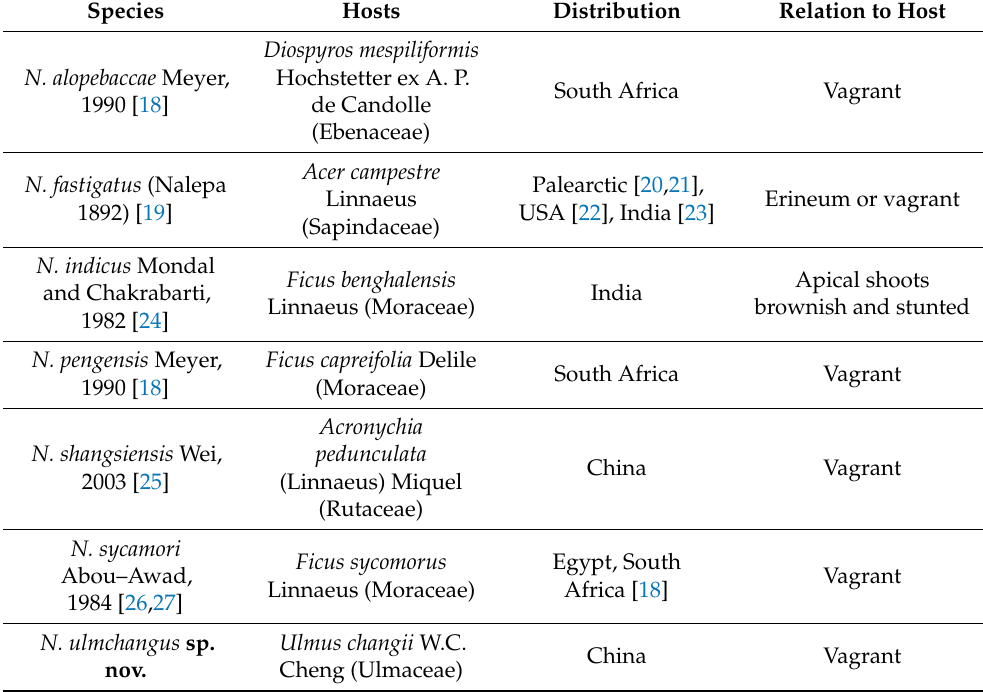
Table 2. List of Neotegonotus